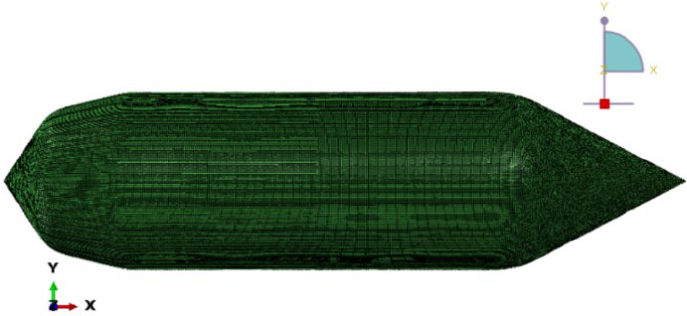
Figure 4. Coupling model. Table 2. Parameters of the simulation environment. Local latitude 41° Local longitude 92° Day of year 174 Altitude 20,000 m Pitch angle of the airship 0° Yaw angle of the airship 0° Roll angle 0° Inflow velocity 10 m/s